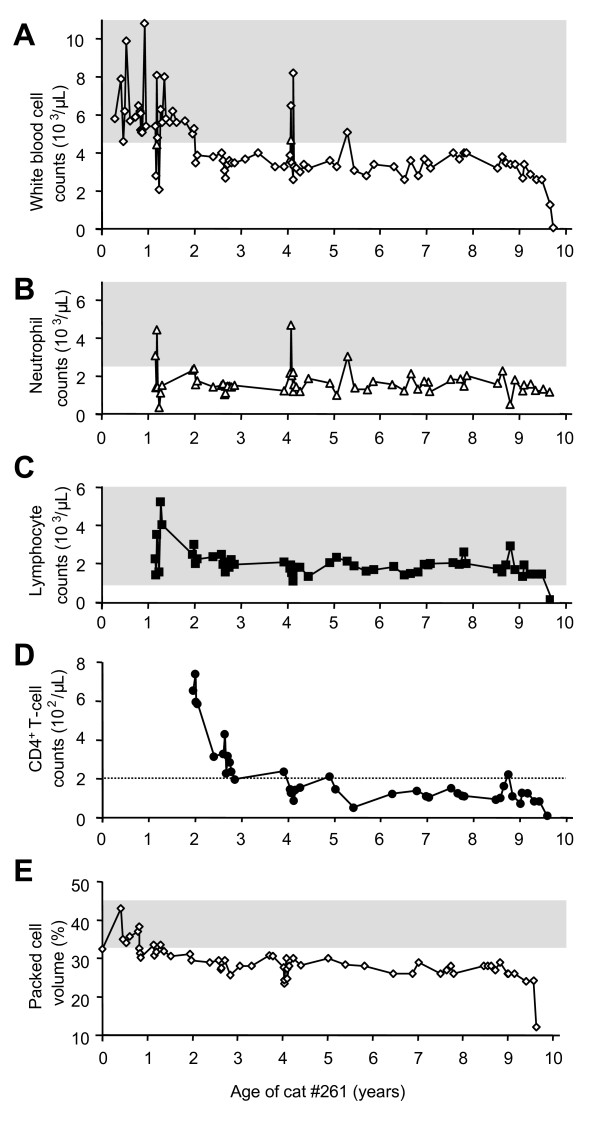
Time course of hematological parameters for cat #261. A) White blood cell counts. B) Neutrophil granulocyte counts. C) Lymphocyte counts. D) CD4+ T-cell counts. E) Packed cell volume. The reference ranges (5th to 95th percentiles) are indicated by the shaded areas (A to C, and E). No reference range was available for the absolute numbers of CD4+ T cells. In panel D, the dotted line indicates a CD4+ T-cell count of 200 CD4+ T cells/μL. No differential was possible at the time of sacrifice due to the low WBC number (100 cells/μL).